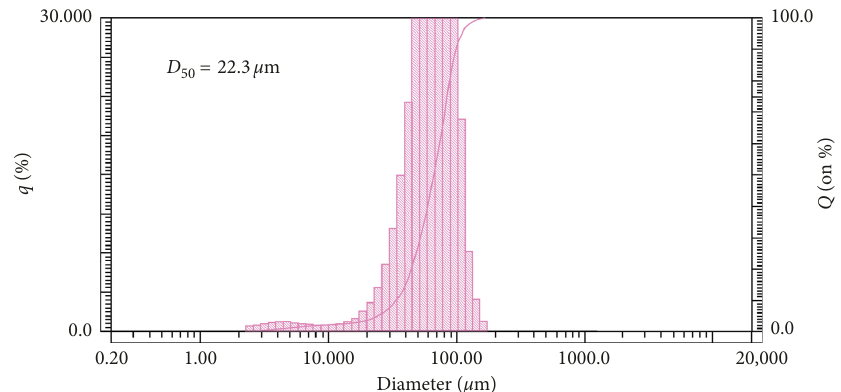
Figure 2: Particle size distribution of LSP.